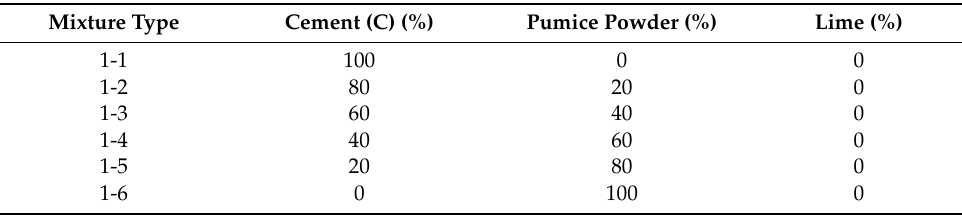
Table 4. Type-1 Mixing Ratios.